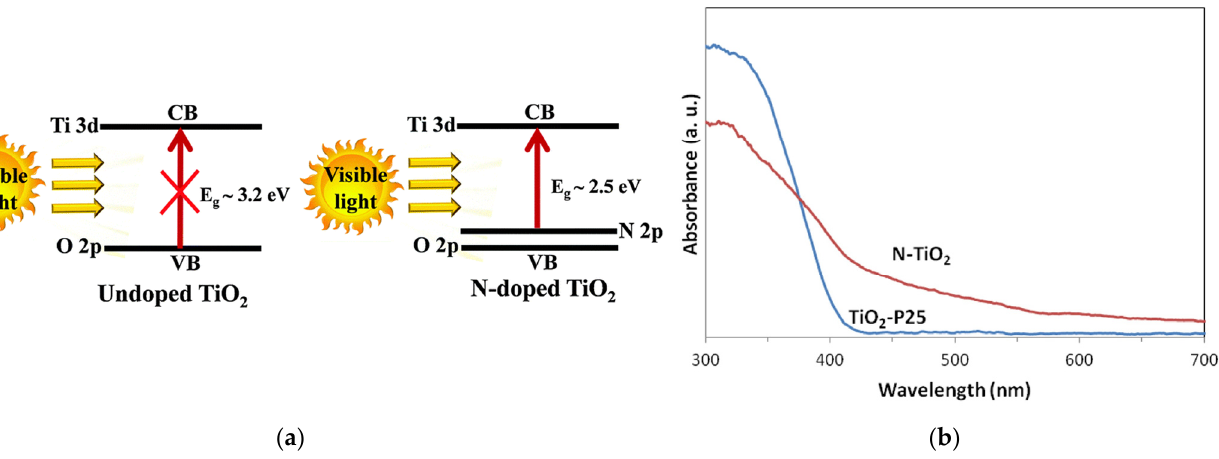
Figure 2. ( a ) Energy diagrams for undoped and N-doped TiO 2 . Reproduced from ref. [51] with permission from the Centre National de la Recherche Scientifique (CNRS) and the Royal Society of Chemistry. Copyright 2016 The Royal Society of Chemistry. ( b ) UV–Vis diffuse reflectance spectra of N-TiO 2 and TiO 2 -P25. Reproduced from ref. [40] with permission from Elsevier. Copyright 2016 Elsevier.